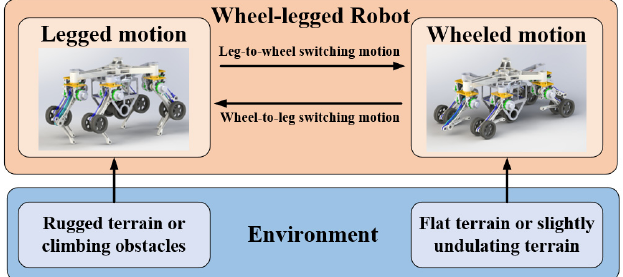
Figure 3. Relationship between motion mode and terrain type.